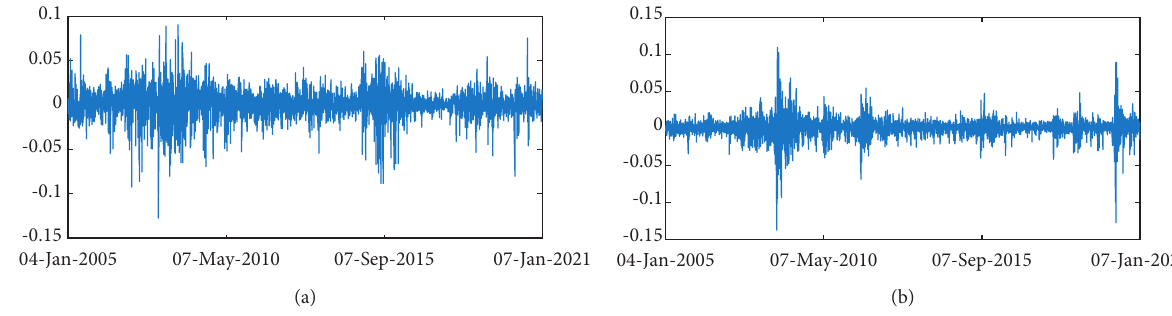
Figure 1: Daily SSEC index and S&P 500 index returns. (a) SSEC: return r